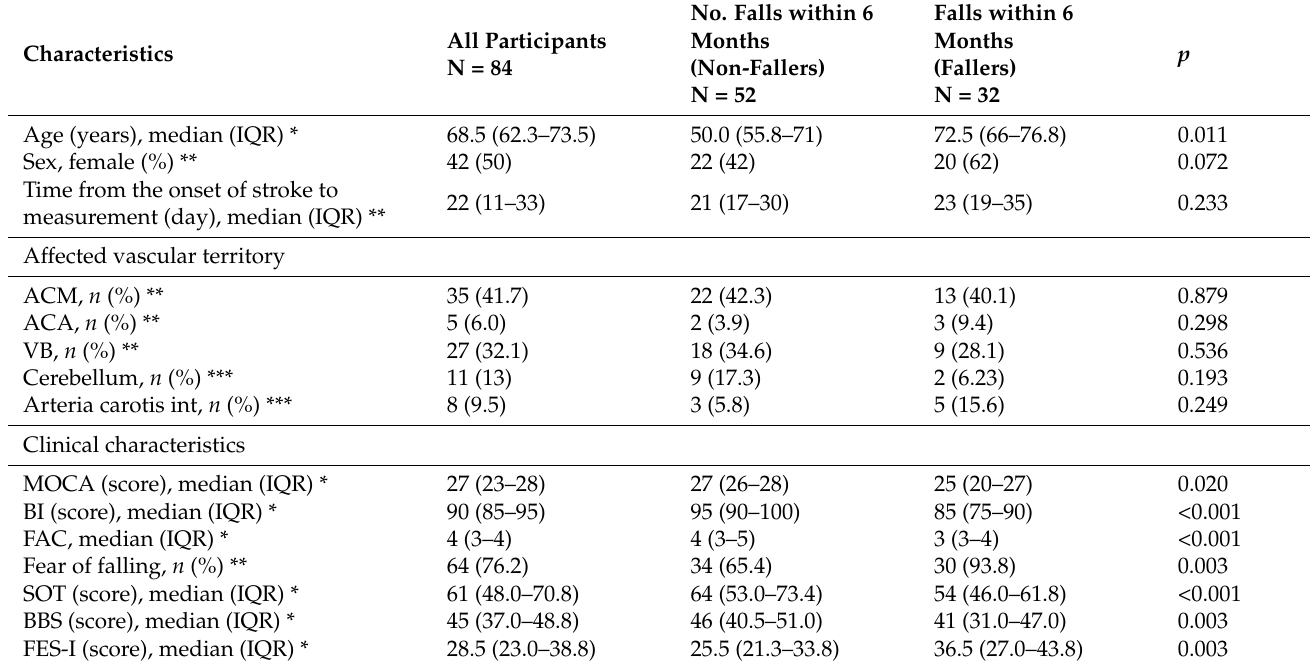
Table 1. Demographic and clinical characteristics of the study participants (N =